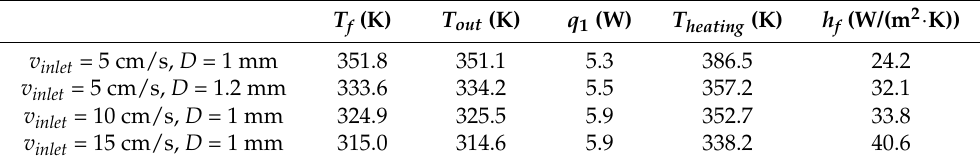
Table 5. Simulation results under different inlet velocities and